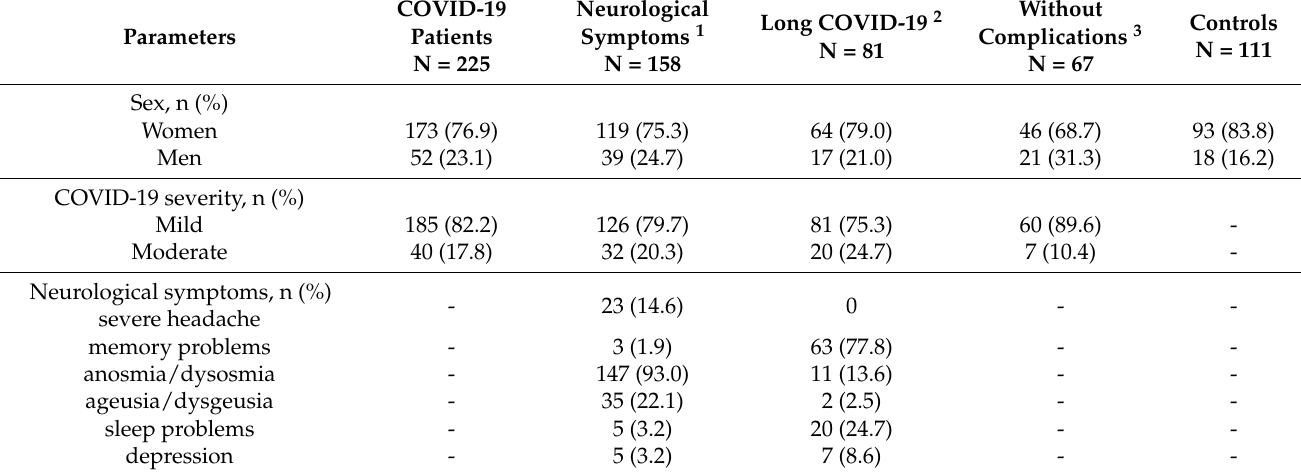
Figure 1. Distribution of the genotype/allele frequencies of FURIN rs1894401 depending on COVID-19 infection susceptibility ( A ), NR1H2 rs1405655 depending on the presence/absence of accompanying neurological symptoms ( B ), and SLC6A20 rs2531743 depending on the presence/absence of neurological consequences over a prolonged period ( C ) in the examined sample of mild-to-moderate COVID-19 cases. Table 1. Characteristics of the study